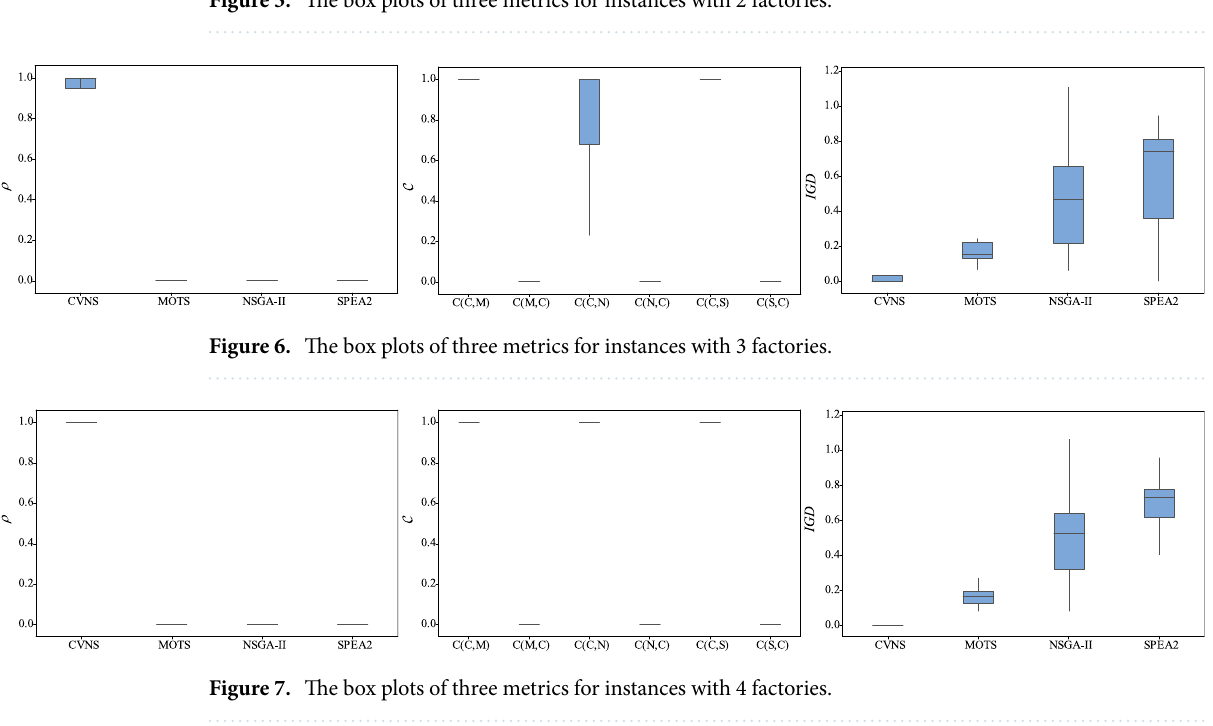
Figure 5. The box plots of three metrics for instances with 2 factories.